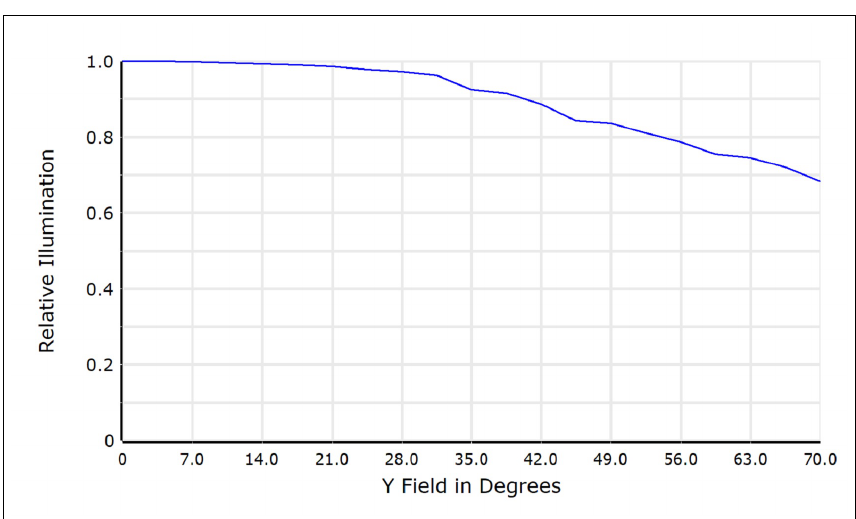
Figure 7. Relative illumination of the optimized